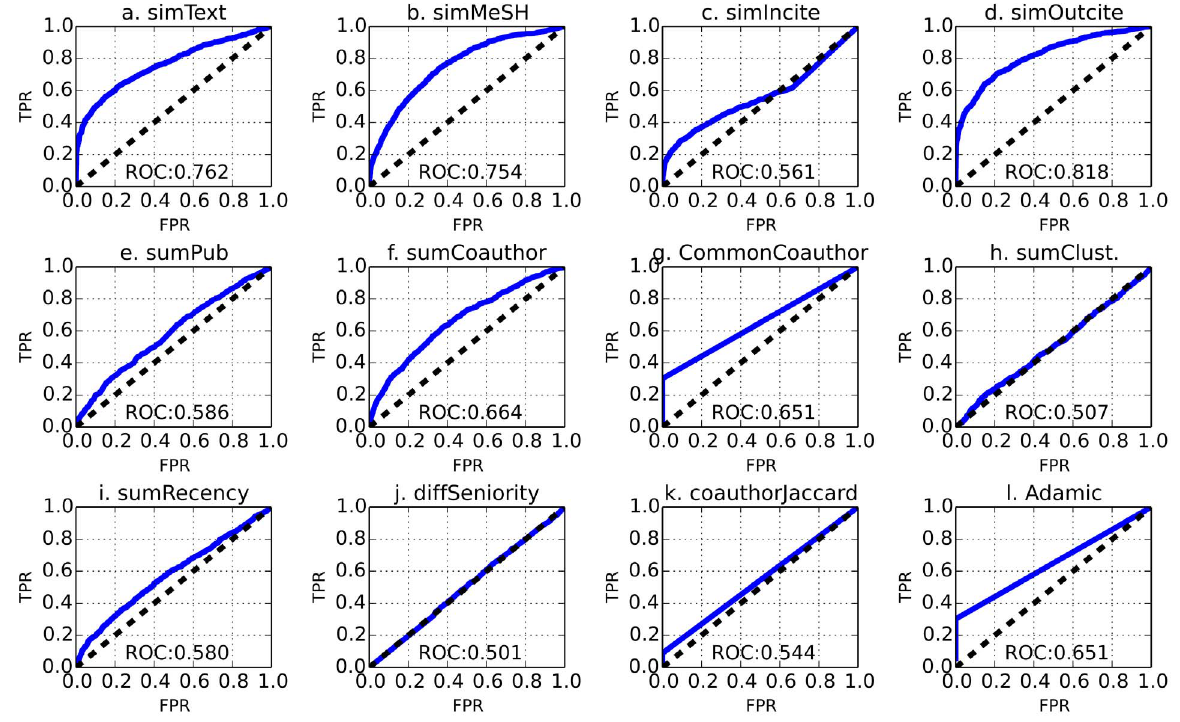
Figure 5. ROC for logistic regression classifiers trained by single feature. 1) Research interest features simText , simMesh and simOutcite (panels a, b and d) have large ROC areas, showing that they are informative for the classification. simIncite (panel c) however is not as large as other features in this category with 0.56 ROC only. 2) The ROC curves for common co-author based features (panels f, k and l) are a straight lines due to the fact that most of the author pairs (especially negative instances) don’t have any common coauthors, and only 1/3 of the positive instances have non- zero common co-authors. 3) Other features such as sumCoauthor (panel f) is also effective for classification with 0.67 ROC. Activity feature sumRecency (panel i) has 0.60 ROC, and so does sumPub (panel e). sumClusteringCoef and diffSeniority (panels h, j) show only 0.53 and 0.54 ROC respectively. The individual ROC is consistent with information gain analysis, which also shows that the research interest features are most informative, followed by common neighbor based features.